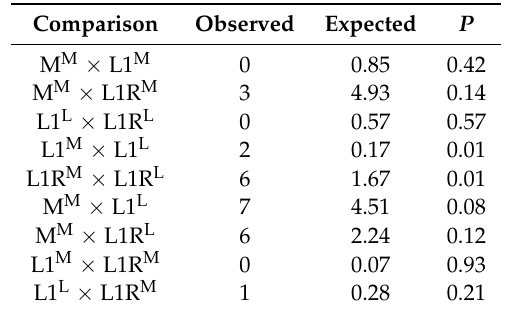
Table 1. Summary of differential expression of cytochrome P450 enzymes. For each comparison, we report the number of differentially expressed cytochrome P450s, the expected number of differentially expressed cytochrome P450s given the number of differentially expressed genes in all and the proportion of genes classified as cytochrome P450s, and the binomial probability of having the observed number of differentially expressed cytochrome P450s by chance. The first three comparisons correspond to genetic differences in expression, the next two to plastic (host) differences in expression, and the final four include genetic and plastic